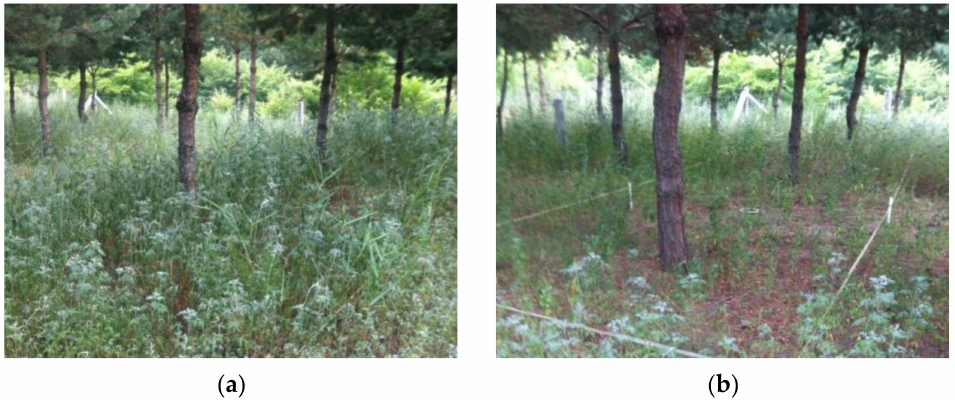
Figure 6. Growth status of understory herbs in Mongolian pine plantation during growing season: ( a ) SL, 25 t ha − 1 (dry weight) composted sewage sludge application plot; ( b ) CK, control treatment without SS application